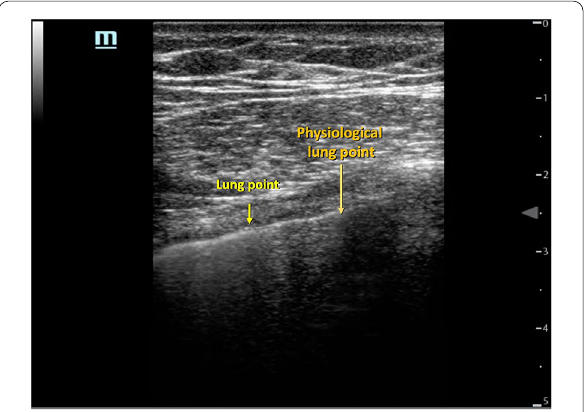
Fig. 7 Lung point sign and mediastinal point sign (Video